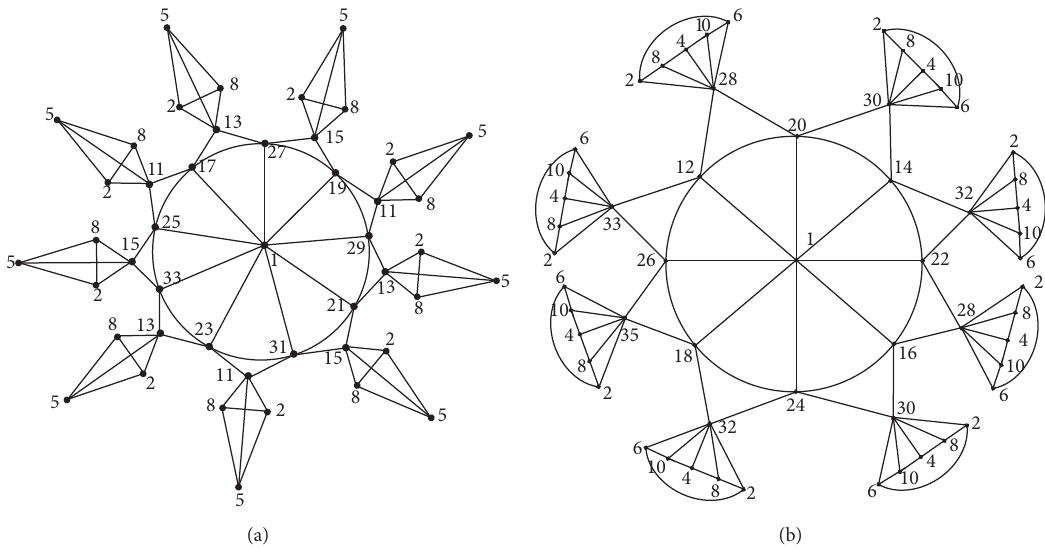
Figure 3: A radial radio labelling of complete-sun graph CS ( n, Ւ ) for n � 9and Ւ � 4 and wheel-sun graph WS ( 8 , 5 )